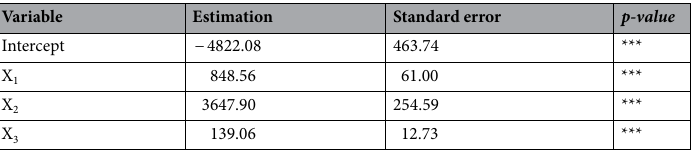
Table 2. Estimation and significance of predictors in model for prediction of biogas production. X 1 , X 2 , X 3 represented VS loading rate of swine manure, waste kitchen oil/swine manure ratio and temperature, respectively. Significance: ***p < 0.001, **p < 0.01, *p <